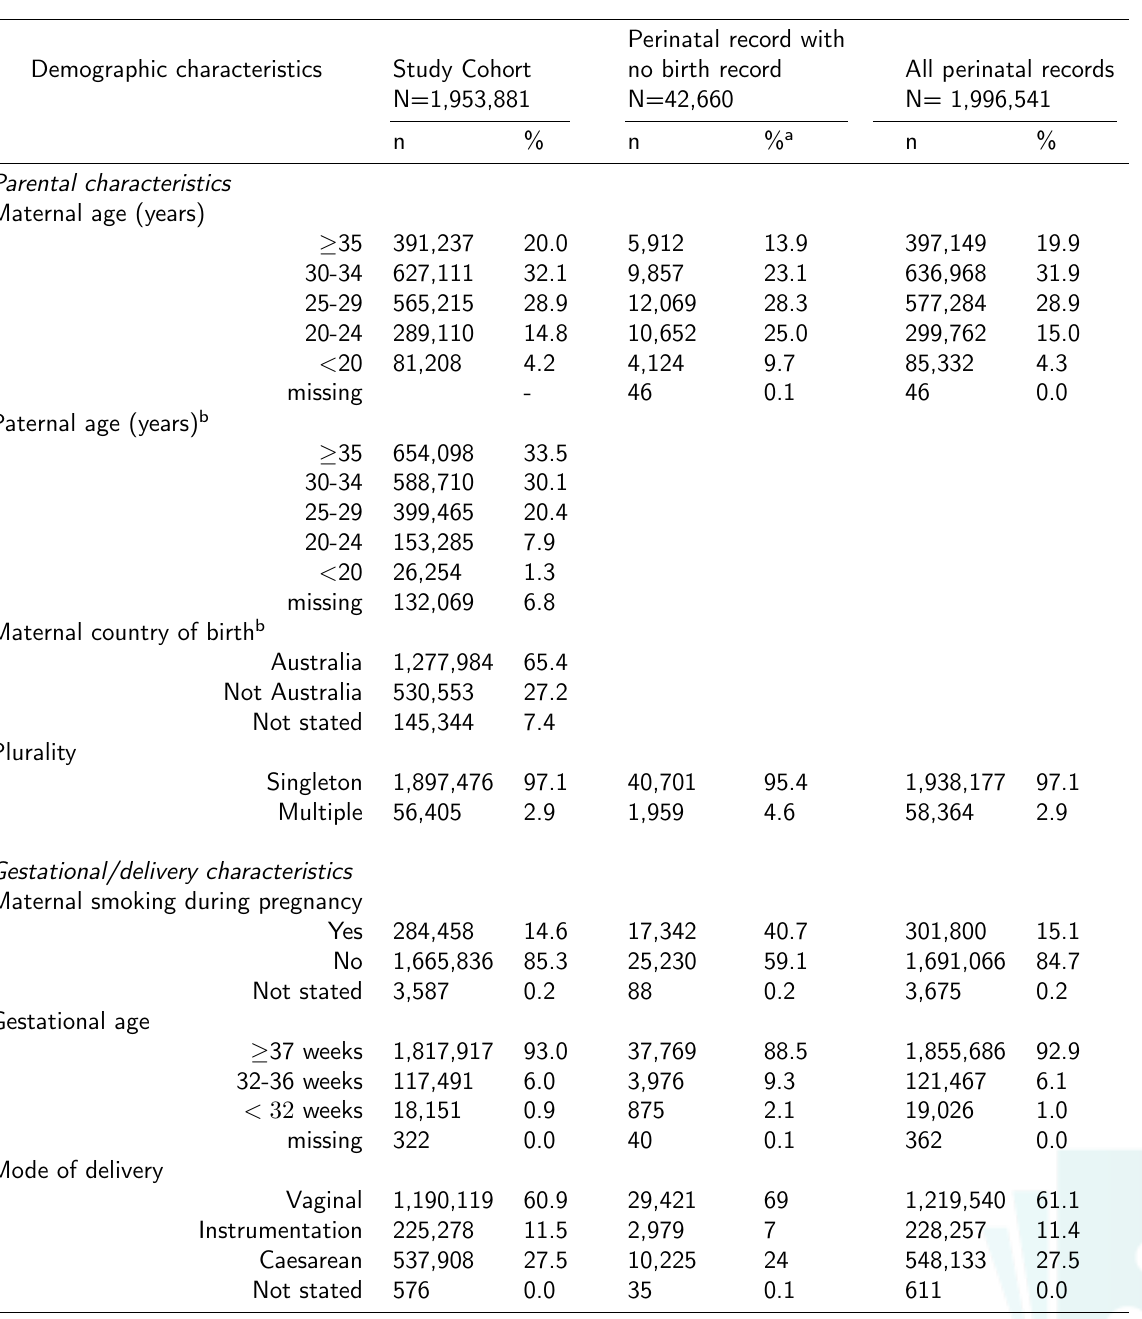
Table 1: Demographic characteristics of the study cohort and comparison with the all live births in the Perinatal Data Collection (representing our source population) and live births with unlinked perinatal